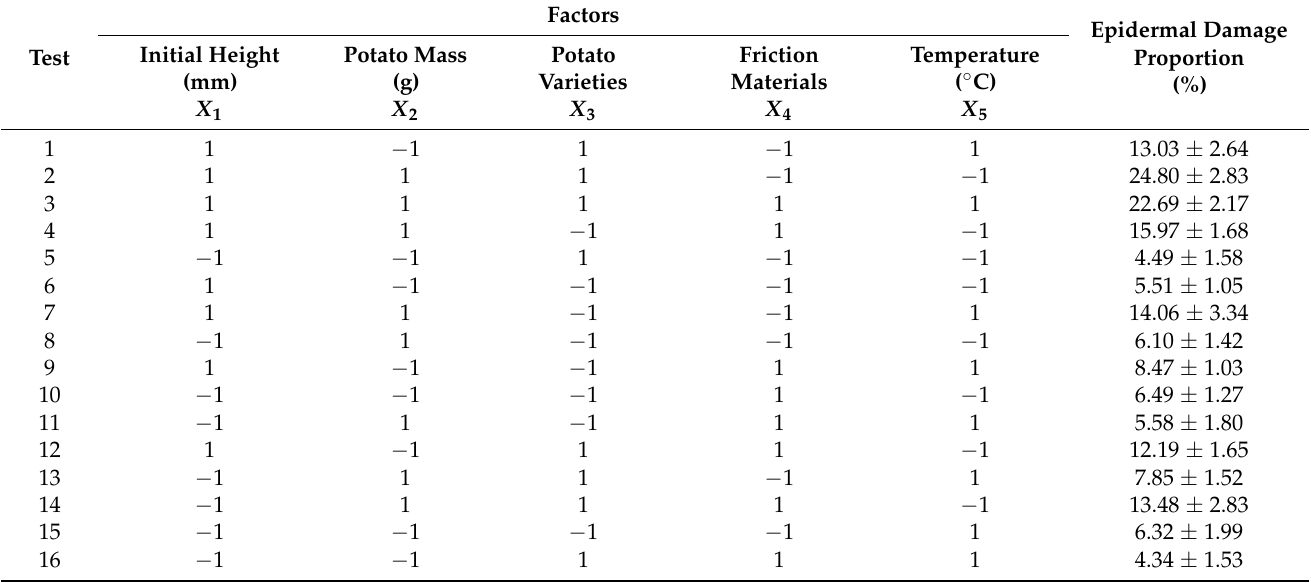
Table 2. Factorial testing design scheme and results